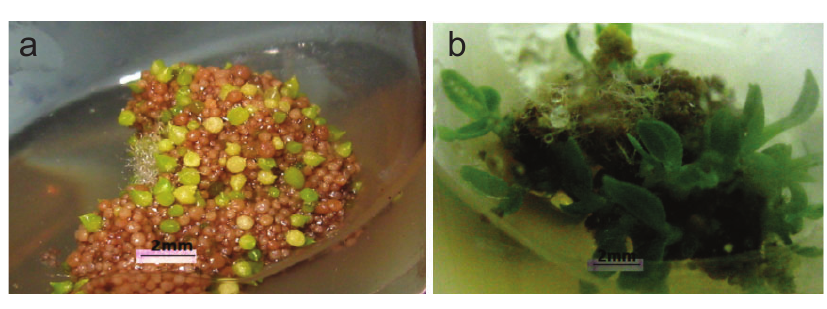
Figure 6. (a) PLB formation on medium without PGR and (b) subsequent plantlet for-